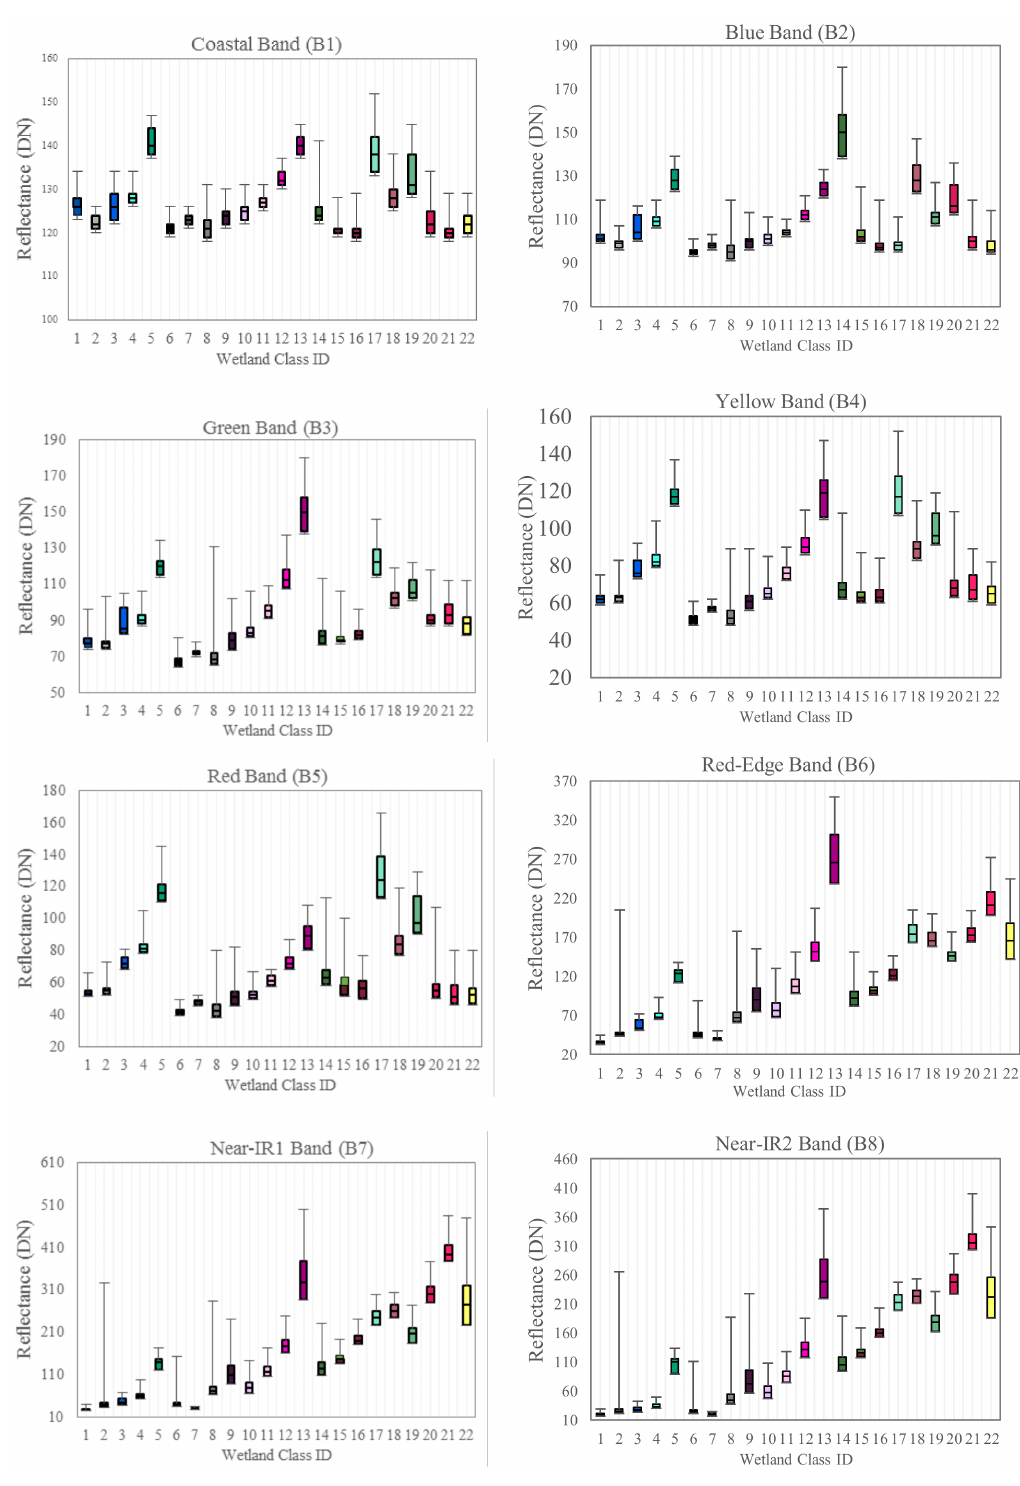
Figure 5. Median WV2 band distribution indicates strong discriminatory power between